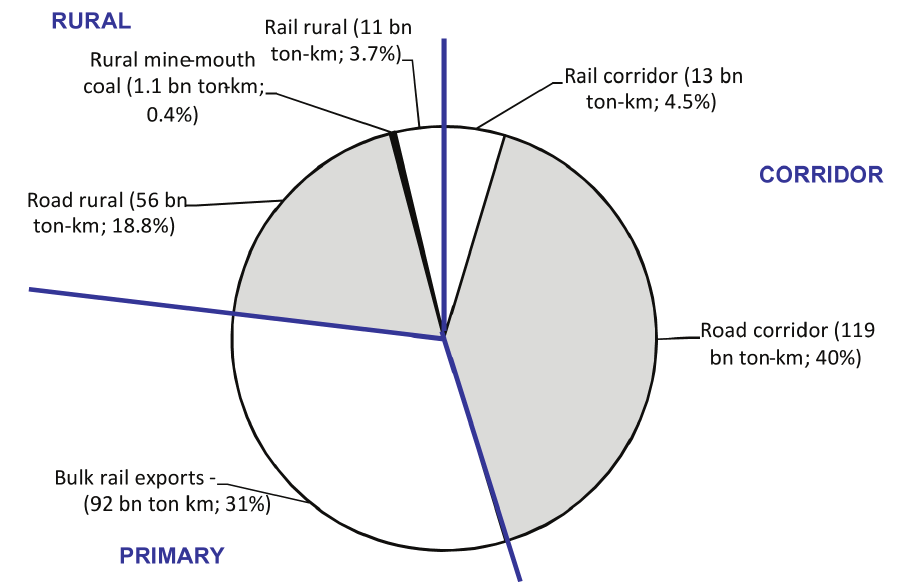
Figure 1: Freight transport by typology: billion ton-km and percentage share (data source: FDM,